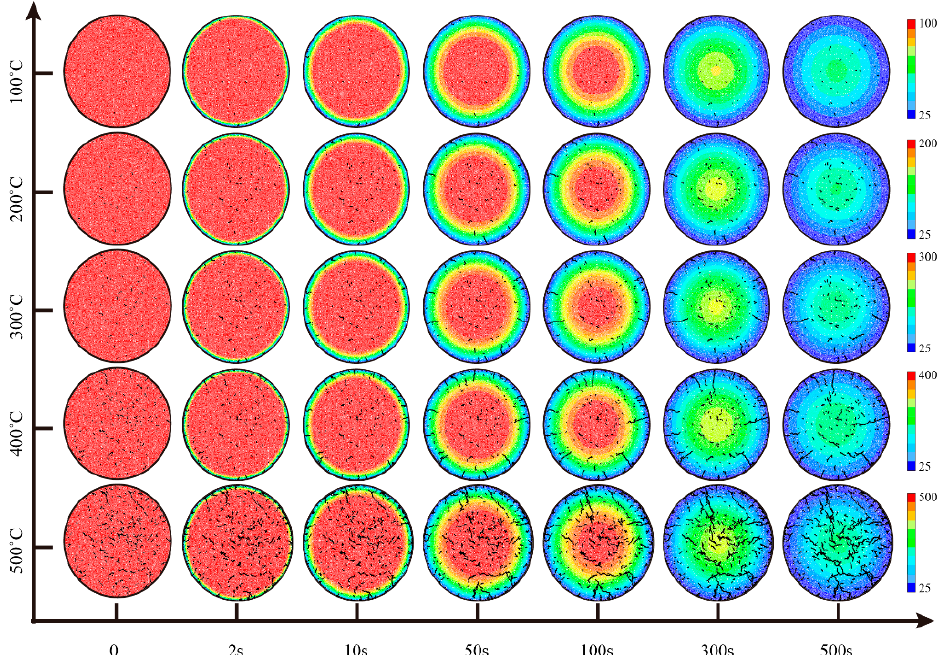
Figure 8. Crack propagation process and temperature fields history for high-temperature granite during cooling.